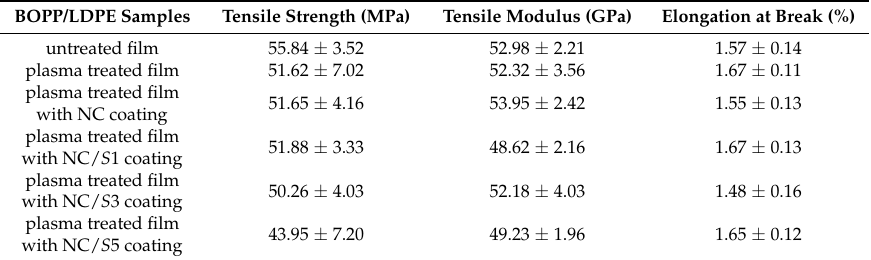
Table 1. Mechanical properties of BOPP/LDPE films under different surface